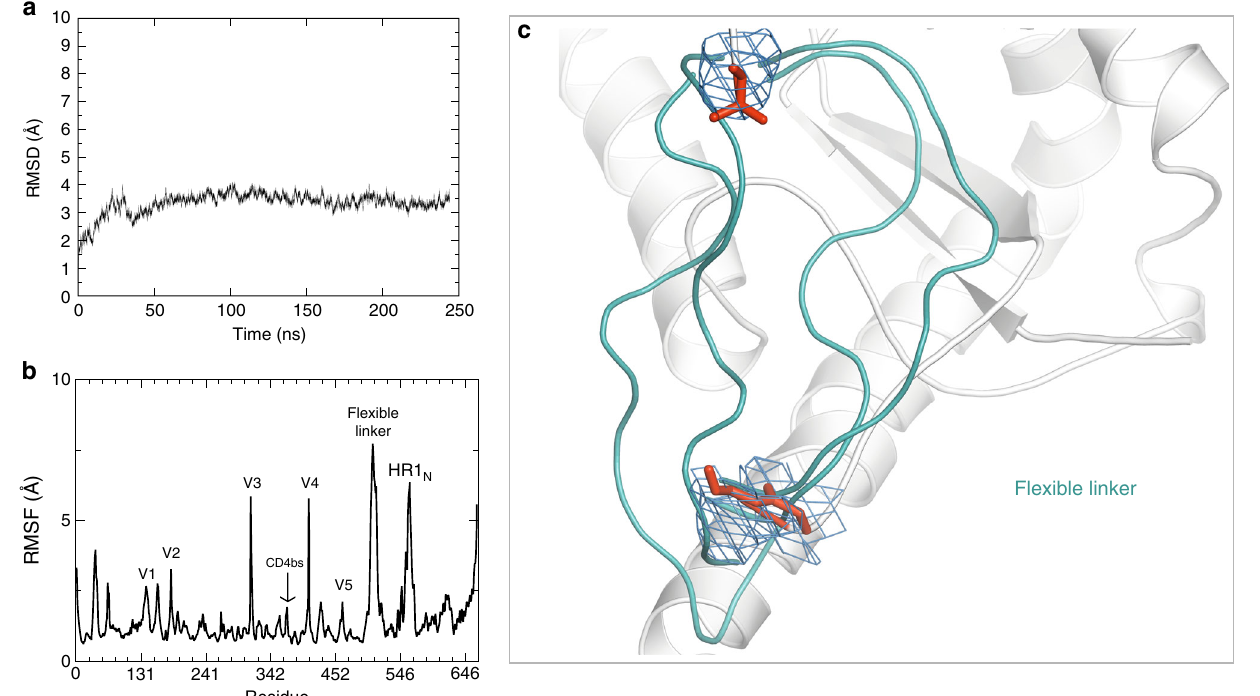
Fig. 3 Linker fl exibility and inherent motion in BG505 NFL.664. a Stabilization of the MD trajectory of BG505 gp140 NFL.664 simulated for 250 ns. b Root mean square fl uctuations of the variable loops of BG505 NFL.664 over the 250 ns trajectory. c The range of movement of the 2xG 4 S linker sampled over the MD simulation